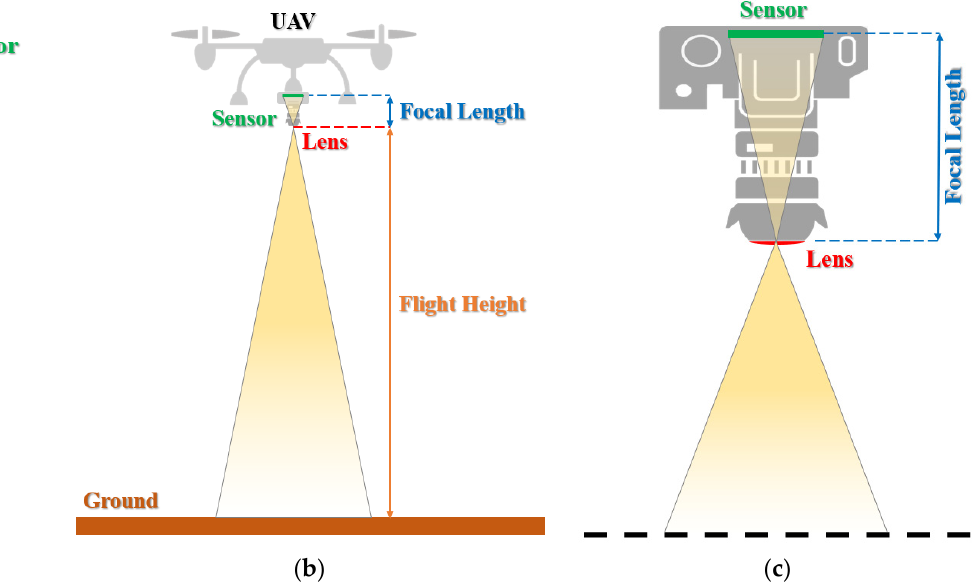
Figure 4. GSD calculation: pixel size and its relation to the GSD ( a ), geometric acquisition ( b ), and detail of main elements of the camera ( c ).